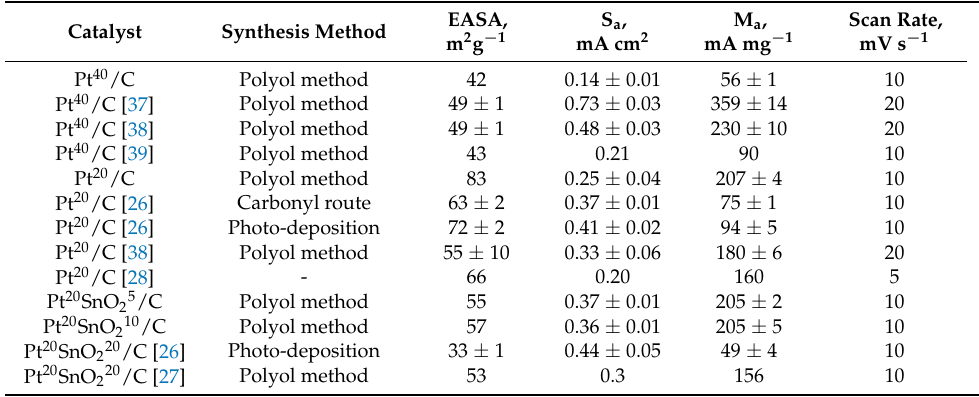
Table 1. Comparison of catalyst parameters: EASA, area-specific (S a ) and mass-specific (M a ) activity Figure 6. RDE polarization curves (20 mV s − 1 ) for the ORR at a Pt 20 /C-coated disk electrode rotating of catalysts at 20 ◦ C and at potential 0.9 at 1600 rpm in a 0.1 M HClO 4 solution at different temperatures in the range from 1 to 50 °C.